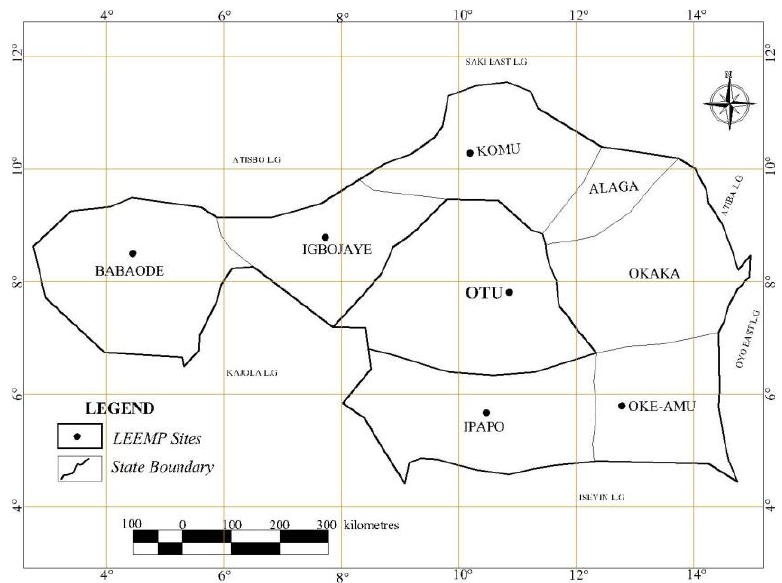
Fig. 3. Map of the Itesiwaju Local Government Area Showing the LEEMP Projects